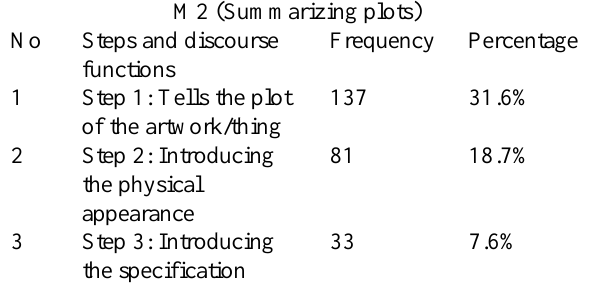
TABLE 4 | Steps and Discourse Function of Move 2 M2 (Summarizing plots)